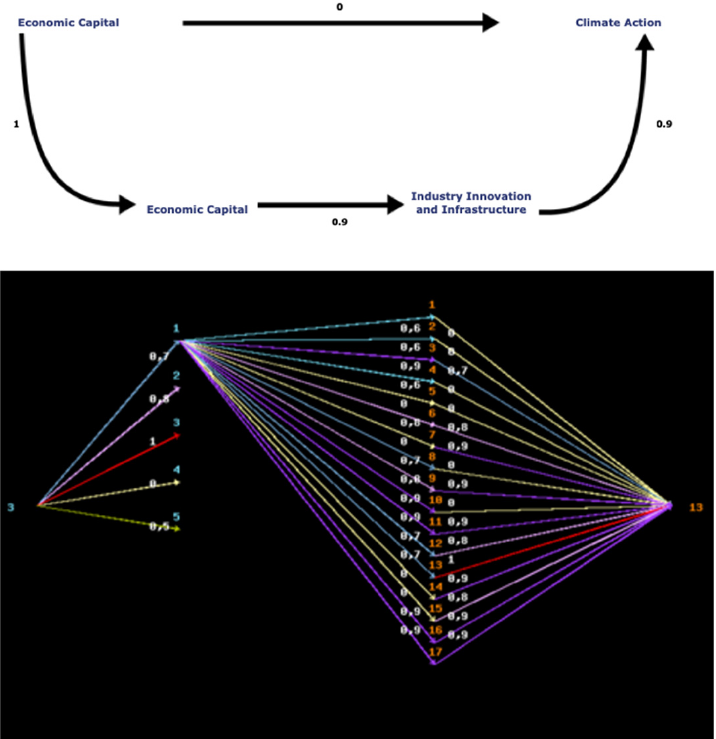
Figure 12. Relation between Economic Capital (H3) and Climate Action (SDG13).